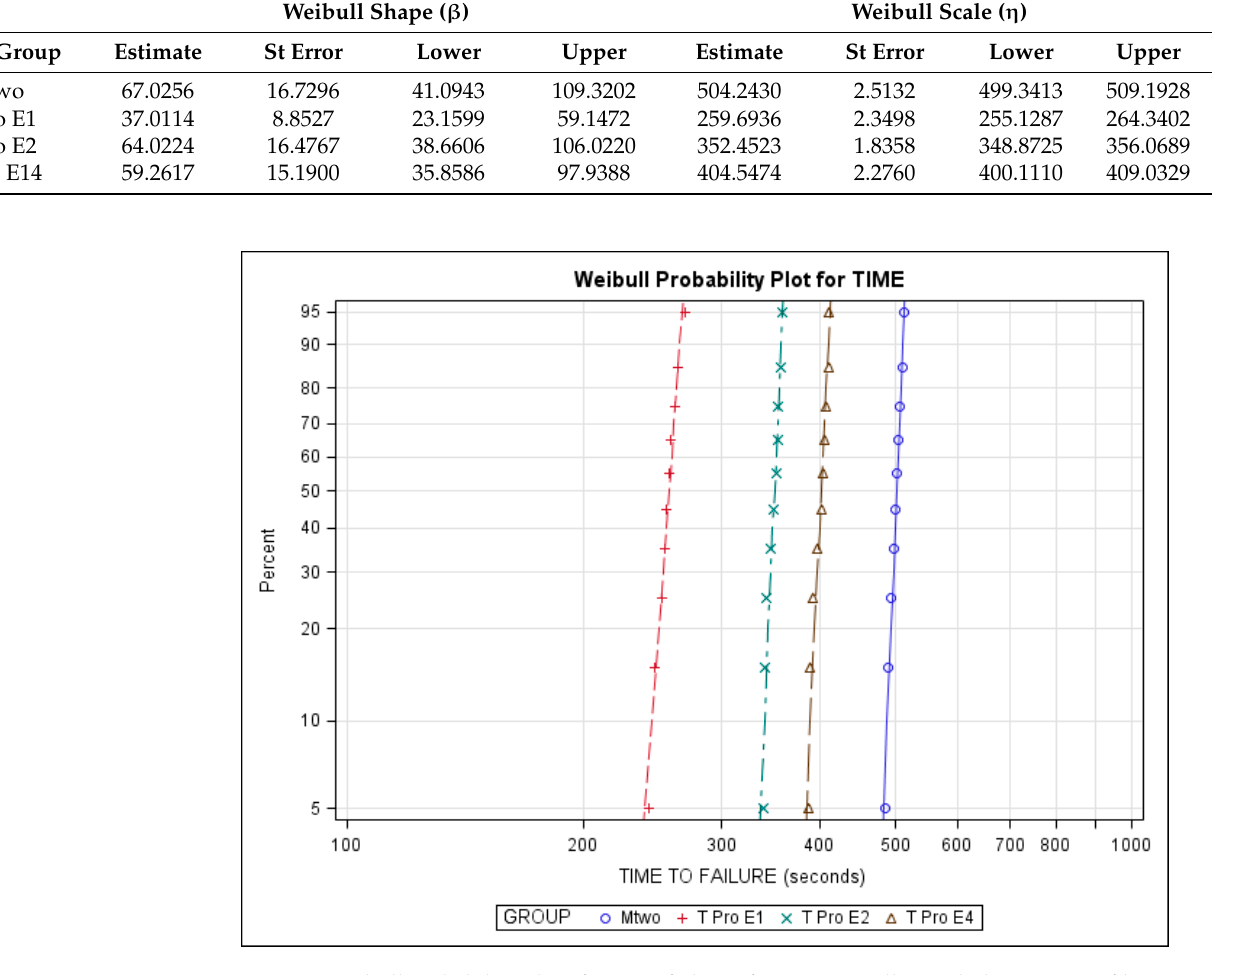
Figure 5. Weibull probability plot of time to failure of Mtwo NiTi alloy endodontic rotary files,